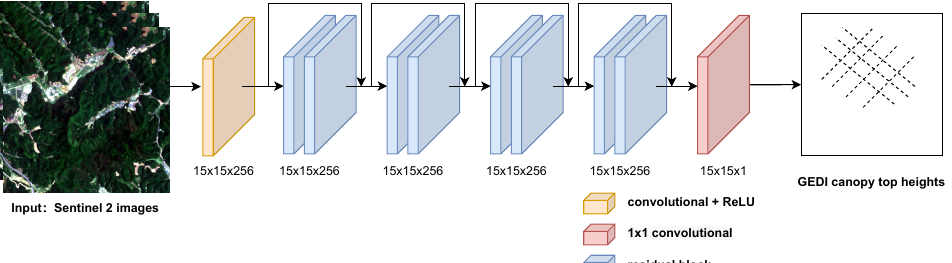
Figure 3. Illustration of the FCN we employed to estimate the canopy top height for every 10 m × 10 m pixel of the Sentinel-2 image. Note that the model was trained with sparse